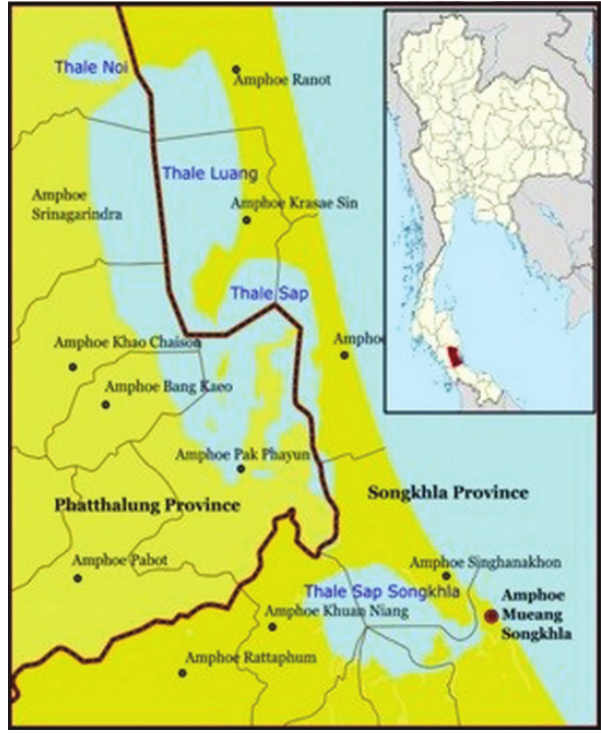
Figure-1: Map of study area, Thale Noi, Phatthalung Province, Southern part of Thailand [Source: https://